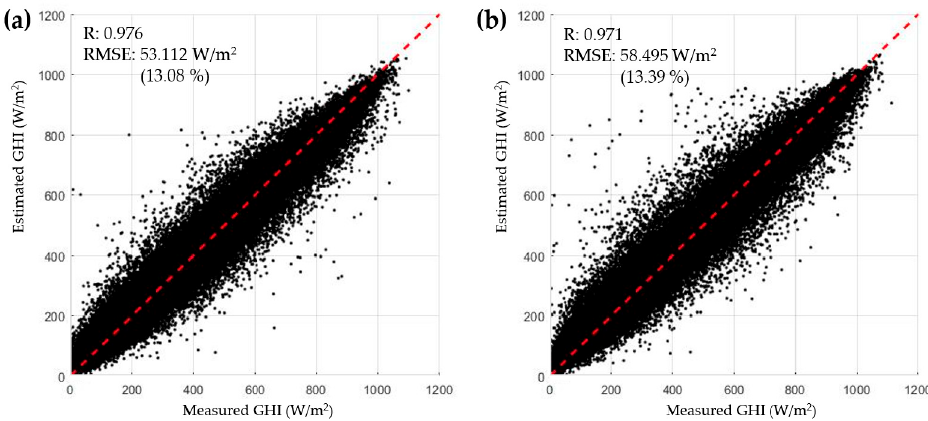
Figure 7. Result of the temporal validation of the ANN model for ( a ) the train dataset (2016), ( b ) the test dataset (2017). Table 3. Monthly accuracy of the temporal validation of the ANN model.